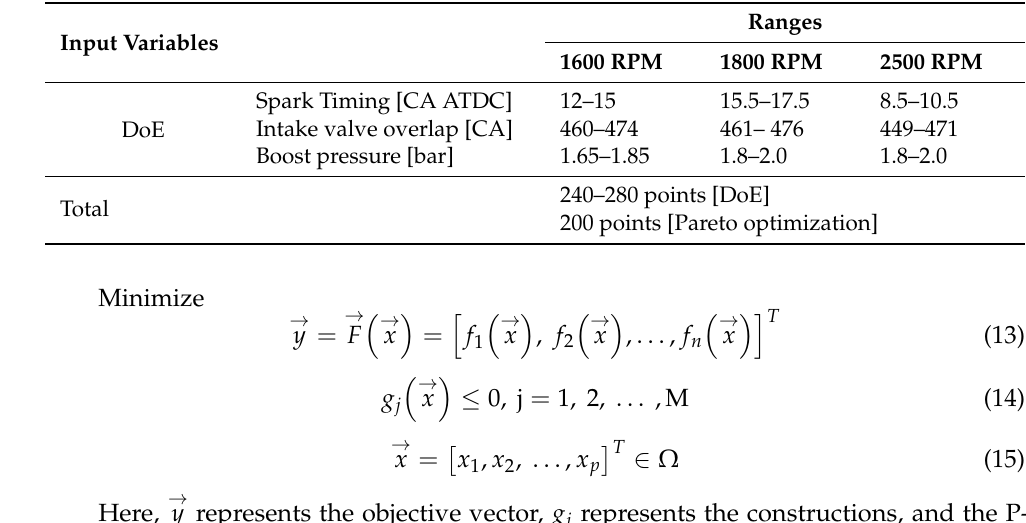
Table 4. Input variables and